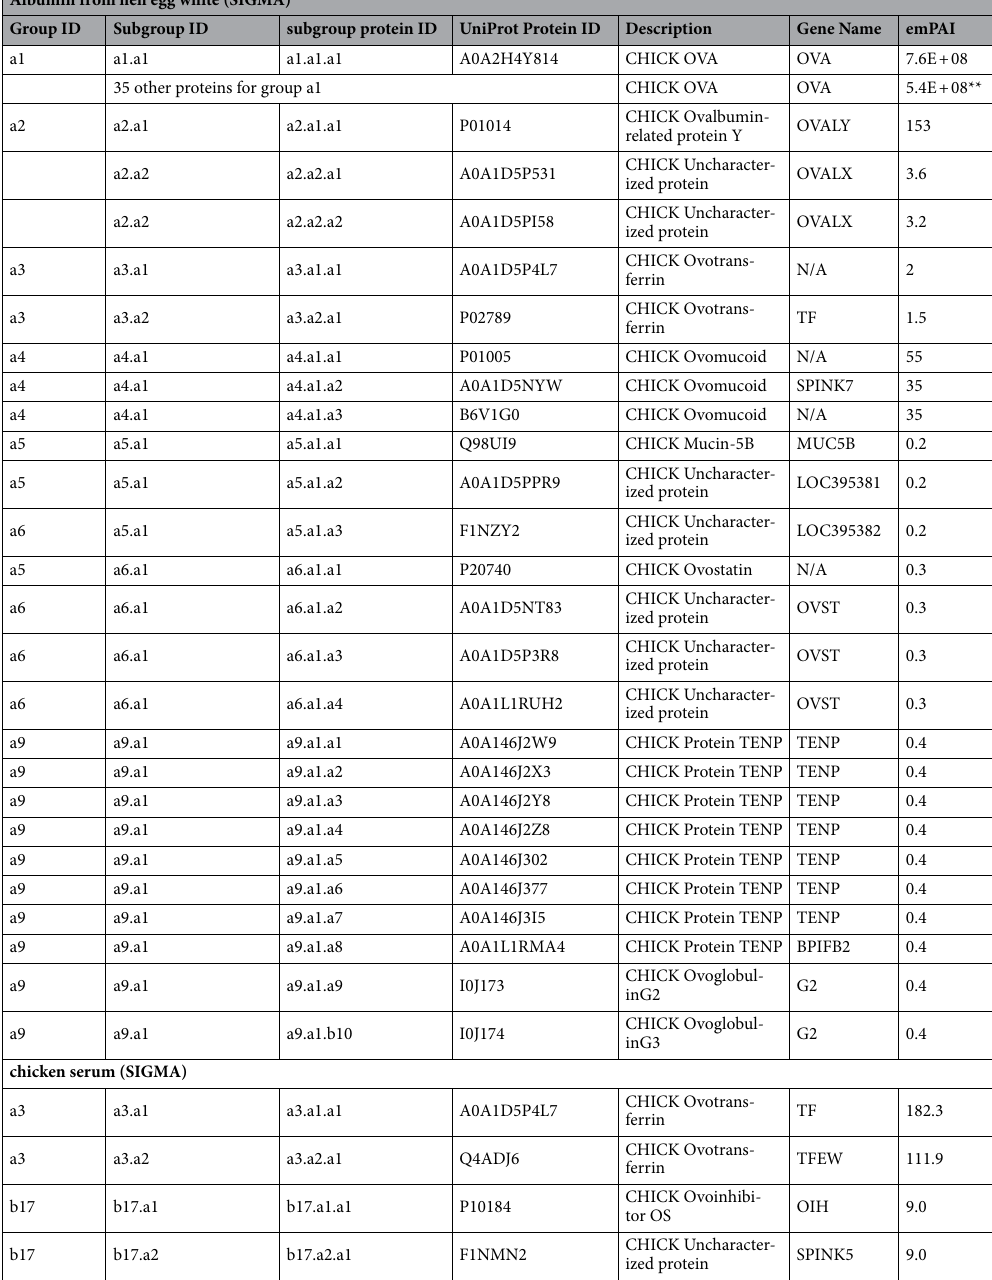
Table 3. Proteins overabundant in female PGCs and identified by LC–MS/MS Analysis of chicken ovalbumin and chicken serum. **Mean emPAI for 35 proteins from group a1 identified as